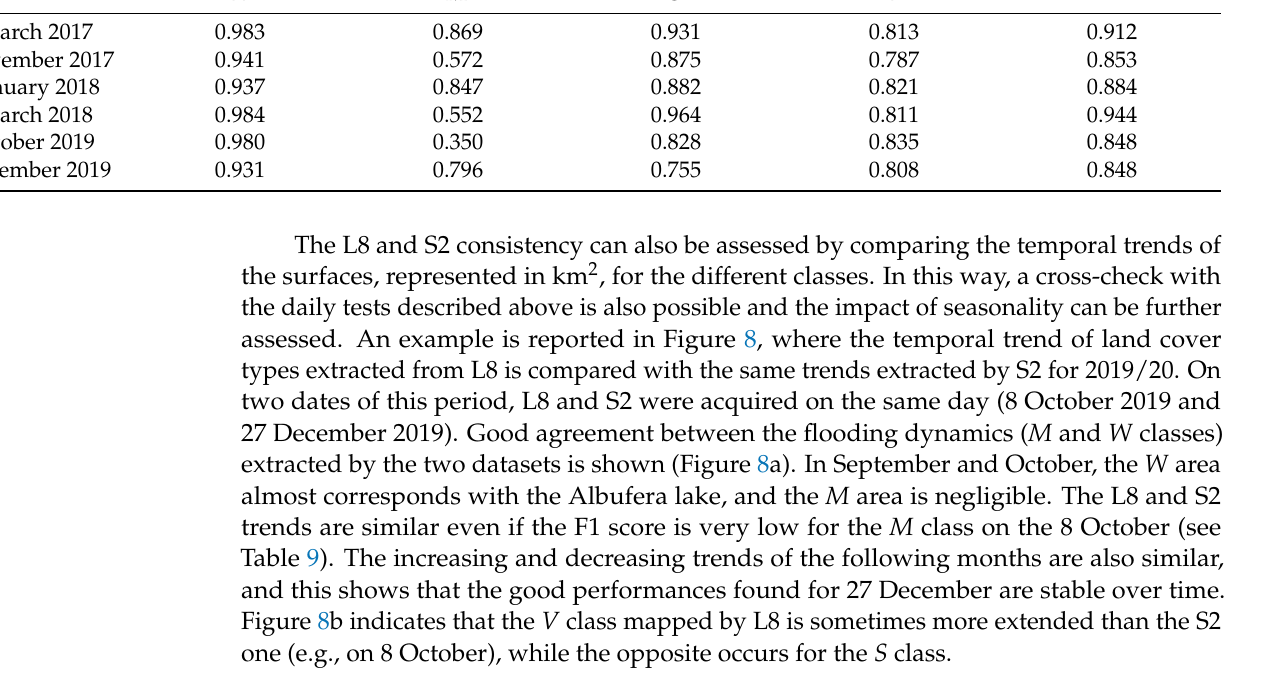
Figure 9. Number of days between two usable images of the L8 and S2 datasets taken individually and of the merged dataset in 2019. 5.5. Observed Land Cover Dynamics One of the most interesting applications of the rule-based classification method con- cerns the monitoring of the spatial distribution and the temporal trend of the flooding. This paragraph shows some examples of the information obtained by the merged S2 and L8 dataset from September to April, outside the rice growing period. Figure 10 shows the